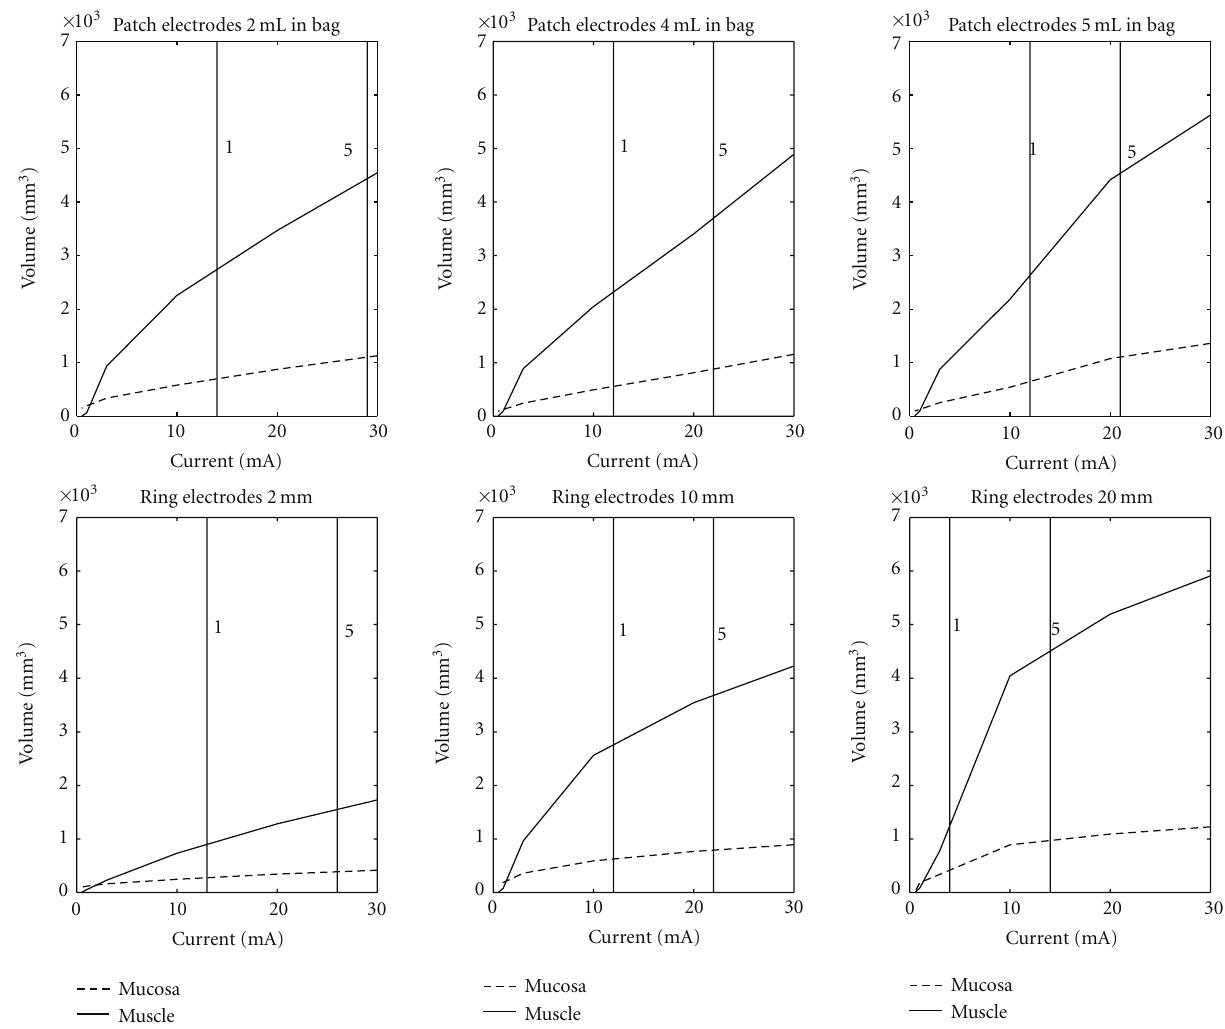
Figure 3: The electrical field which exceeds a threshold of 20 V/m in the three anatomical layers is illustrated. The stimulation current range of the di ff erent stimulation electrodes is illustrated as the window between the sensory threshold (VAS 1) and the pain detection threshold (VAS